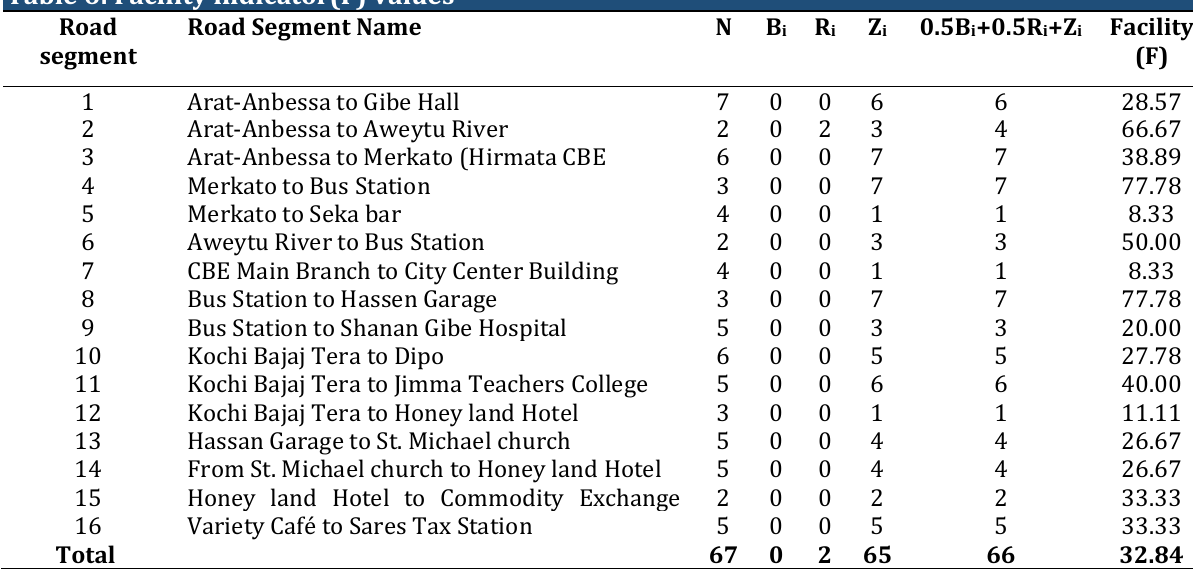
Table 6: Facility indicator(F)